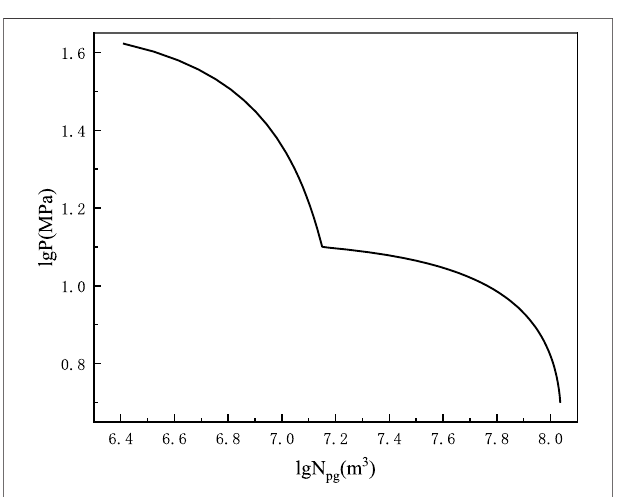
FIGURE 4 | Allocation production versus the cumulative gas production double logarithm chart of Well #1 shale gas Block